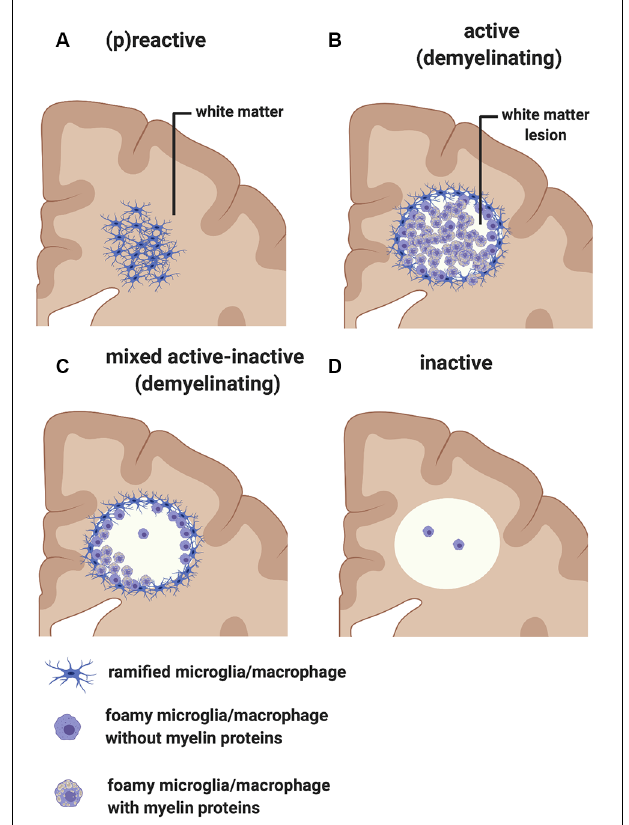
FIGURE 3 | Classification of white matter lesions in multiple sclerosis (MS). Schematic diagram illustrating different types of MS white matter lesions, including (A) (p)reactive sites, (B) active demyelinating lesions, (C) mixed active-inactive demyelinating lesions, and (D) inactive lesions. See the text in “MS White Matter” section for a detailed description of each lesion